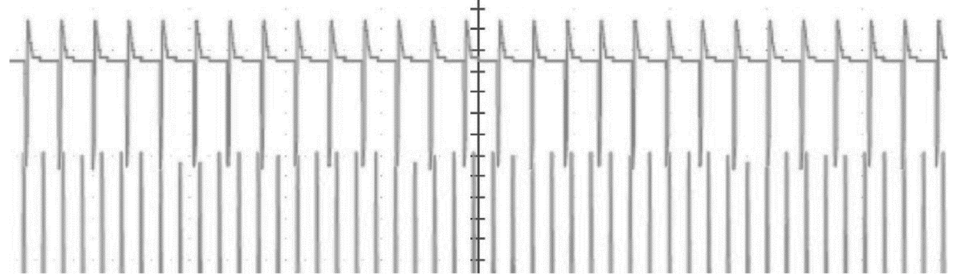
Figure 9. Subsequent periods of the piston compressor shaft and the shaft of the driving electric motor: upper run—signal of the compressor shaft marker; bottom run—signal of the electric motor shaft marker.